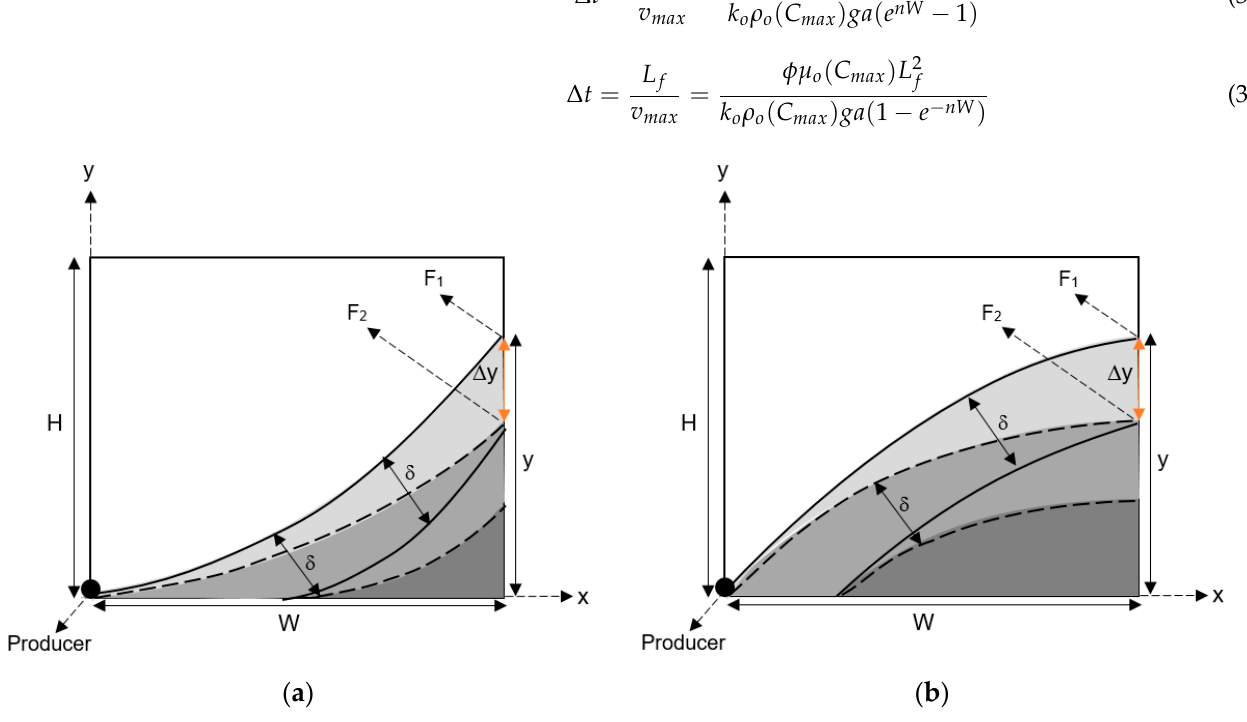
Figure 7. Axial falling of the chamber during the falling stage of the ( a ) concave case and ( b ) convex case.